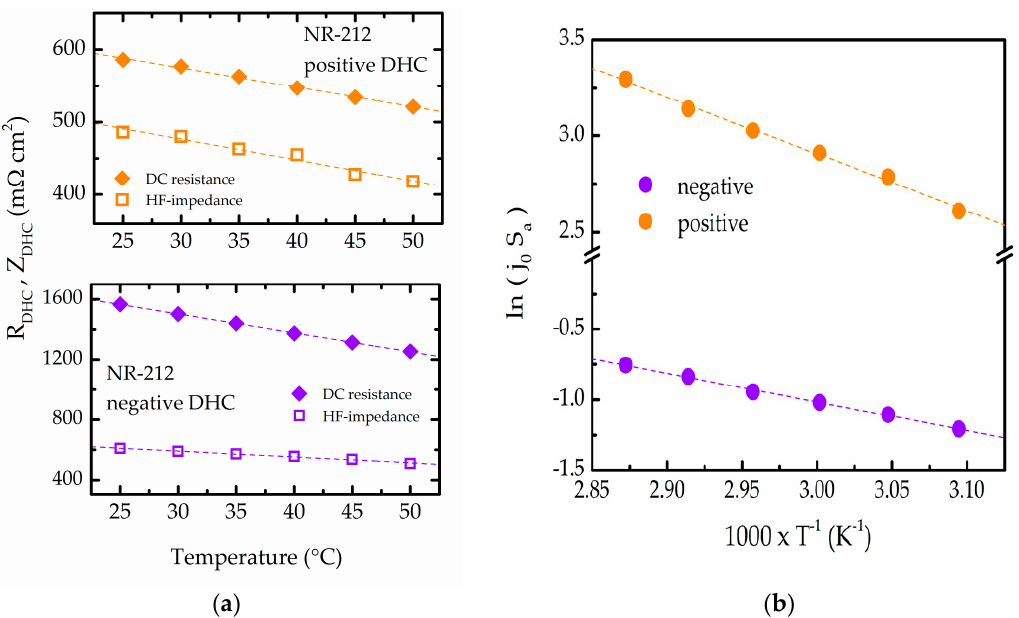
Figure 4. ( a ) Positive and negative DHC resistances (R) and high-frequency impedances (Z) for a cell using Nafion ® NR-212 membranes at different temperatures. ( b ) Calculated volumetric exchange current densities (natural logarithm) for both half-cell reactions at different temperatures.